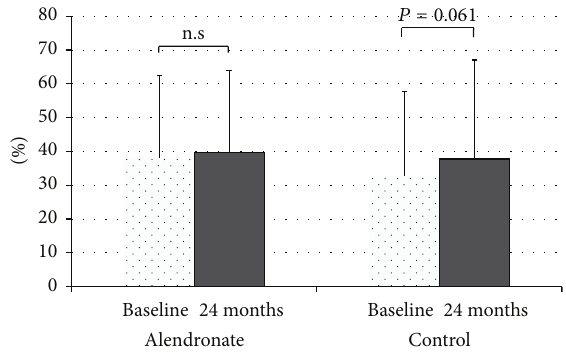
Figure 4: Change in aortic calcification